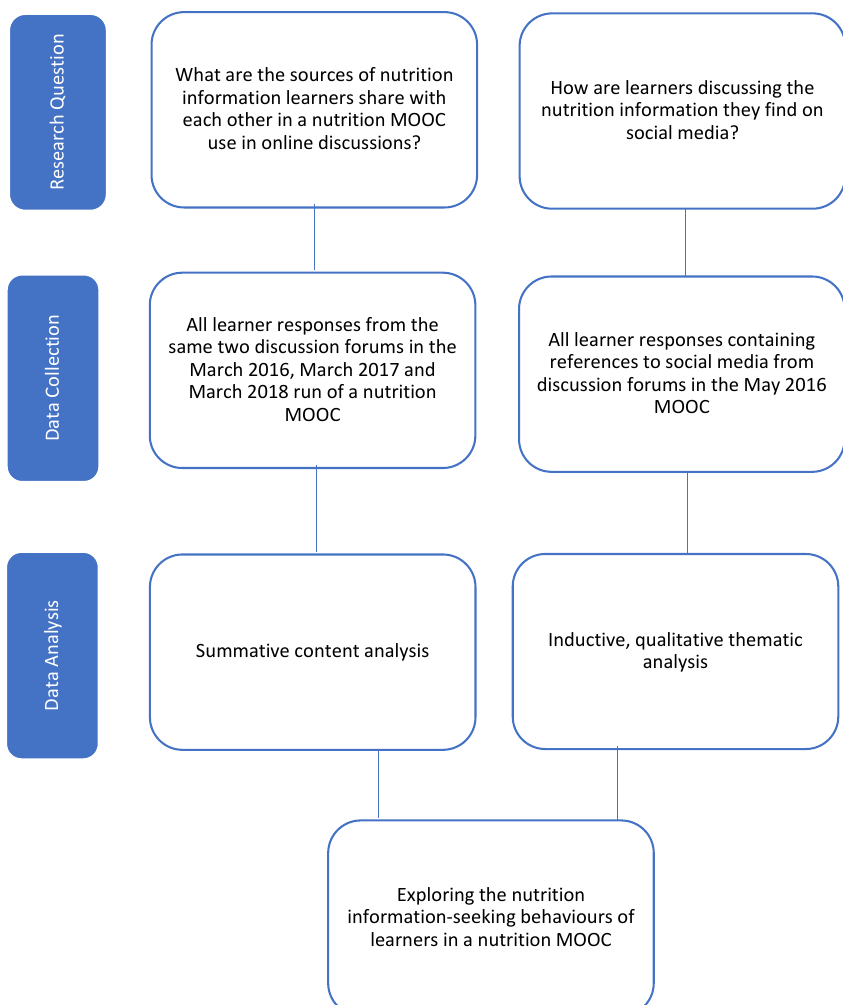
Figure 1. Overview of multi-methods approach and data collection of qualitative data.